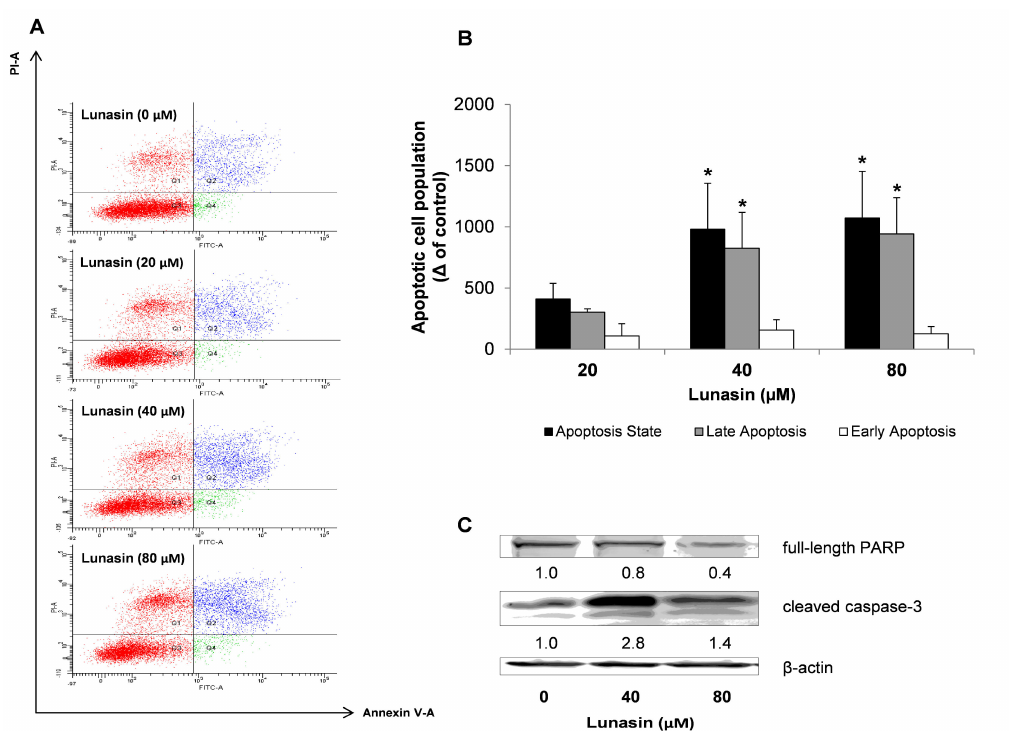
Figure 3. E ff ect of lunasin on the apoptosis state of colon tumorspheres. Cells were treated with lunasin at the indicated concentrations for 7 days, and harvested for apoptosis analyses and Western immunoblotting. ( A ) Flow cytometry-based Annexin V / PI double labeling of apoptotic cells. ( B ) Total apoptotic cells were identified as Annexin V-positive cells (apoptosis state), being Annexin V-positive / PI-negative and Annexin V-positive / PI-positive cells identified as early apoptotic and late apoptotic cells, respectively. Results, presented as the increased number in apoptotic cell populations compared to control cells, are means ± standard deviation (SD) of the replicates of experiments carried out. * ( p < 0.05) significantly di ff erent from control. ( C ) Expression of full length PARP and cleaved caspase-3 proteins determined by Western Blot. The numbers underneath the blots represent band intensity that was normalized to β -actin and measured by Image J software (means of duplicates, and standard deviations within ± 15% of the means were not shown). β -actin was served as an equal loading control for cytosolic